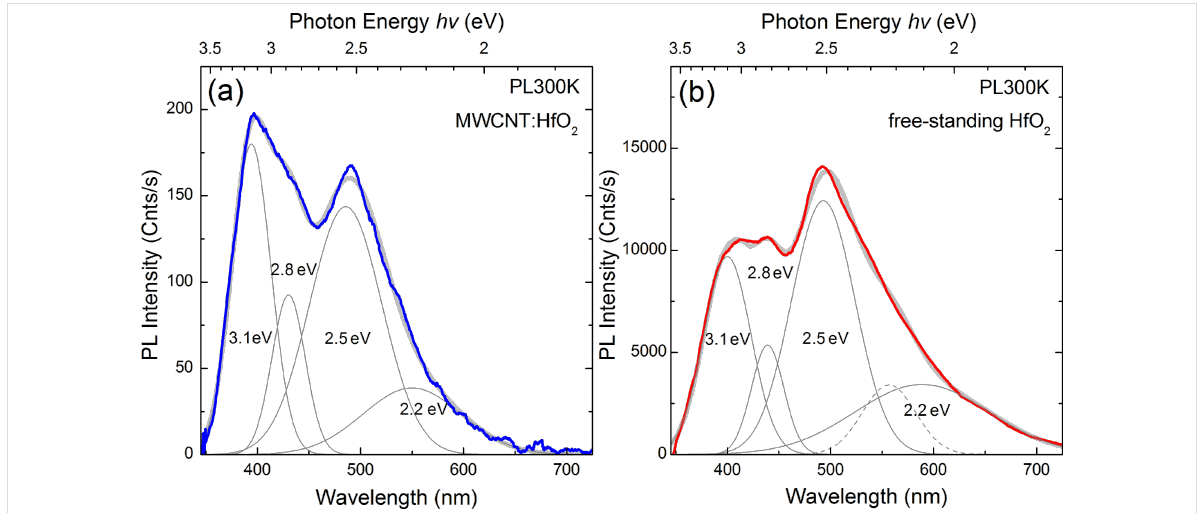
Figure 3: (a) Room temperature photoluminescence spectra of MWCNTs decorated with cubic HfO 2 nanoparticles (from a colloidal suspension in ethanol) compared to (b) free-standing HfO 2 nanoparticles. Grey curves represent the Gaussian deconvolution components. Note different the photo- luminescence intensity scales in (a) and (b).